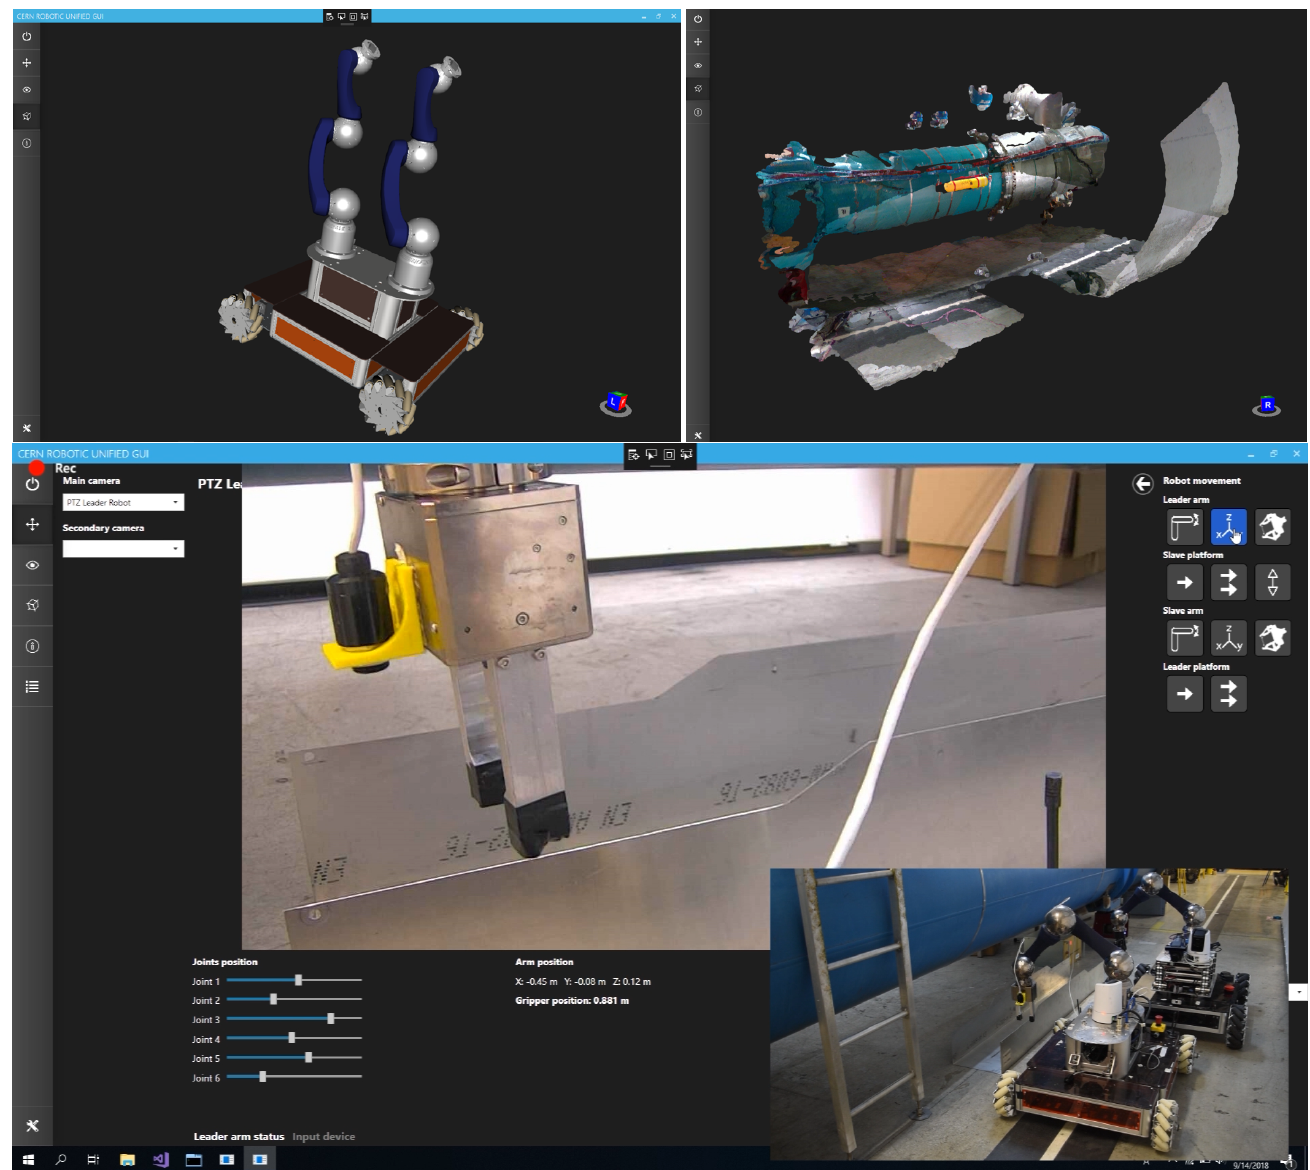
Figure 4. Unified Graphical User Interface to let the operator remotely control the robots in the accelerators and scientific